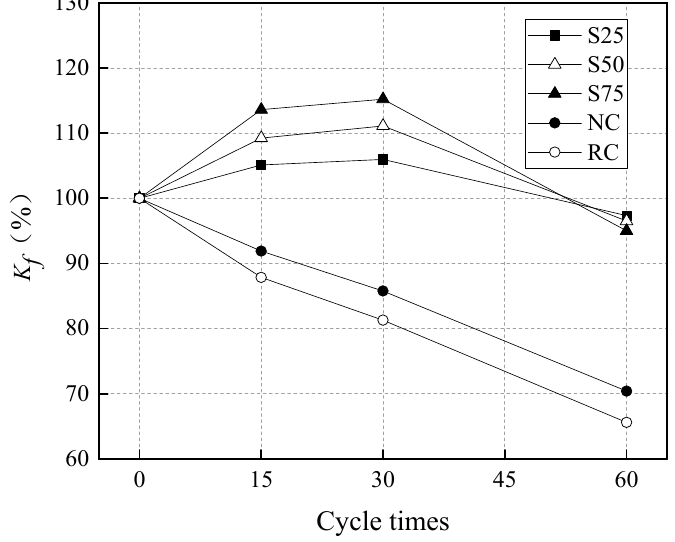
Figure 4. The influence of sulfate attack cycles on the compressive strength of specimens.